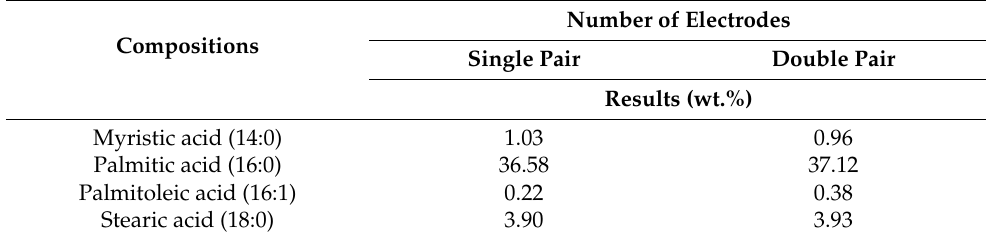
Table 1. Fatty acid compositions of biodiesel after being water-electrolyzed by single- and double-pair electrodes with an input electrical energy of 9 J/(g palm